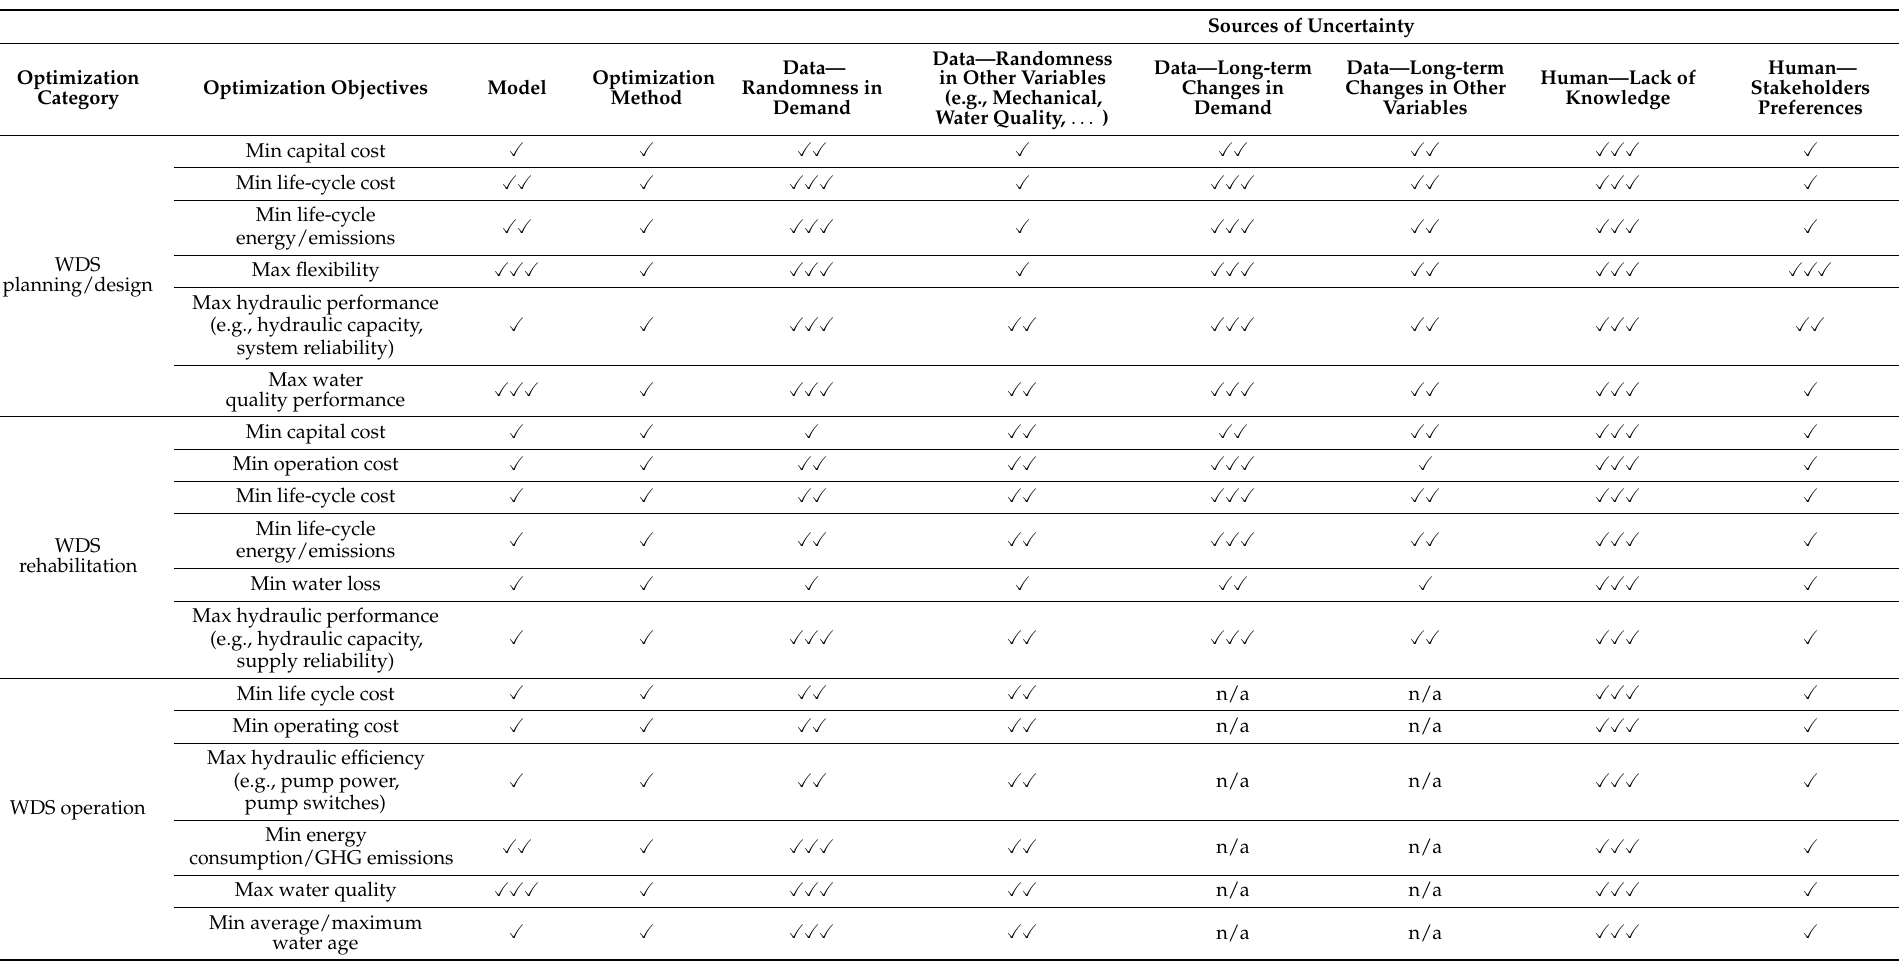
Table 1. Relative importance of the various sources of uncertainty on each objective (three ticks indicates a high level of importance, two ticks a medium level and one tick a low level of importance; n/a means not applicable).